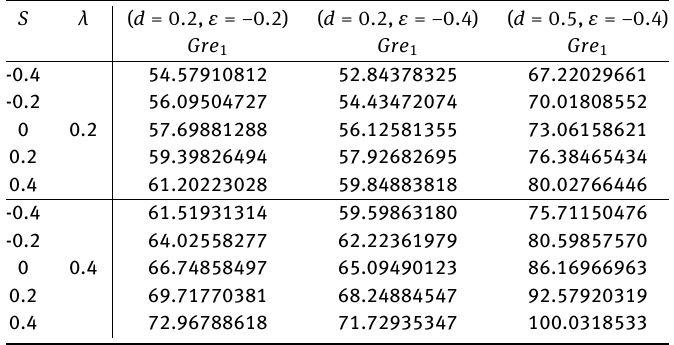
Table 2: Critical values of Gre at the stationary plate y = 1 for different values of S , λ , d and ε where q = 1 and Br = 0.2